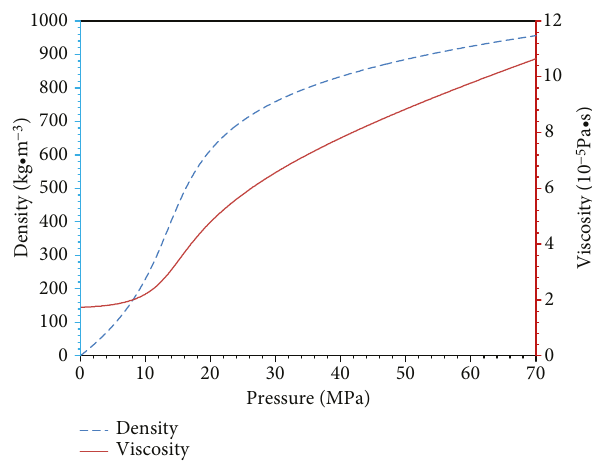
Figure 1: The evolution of density and viscosity of CO pressure ( T = 76 8 °